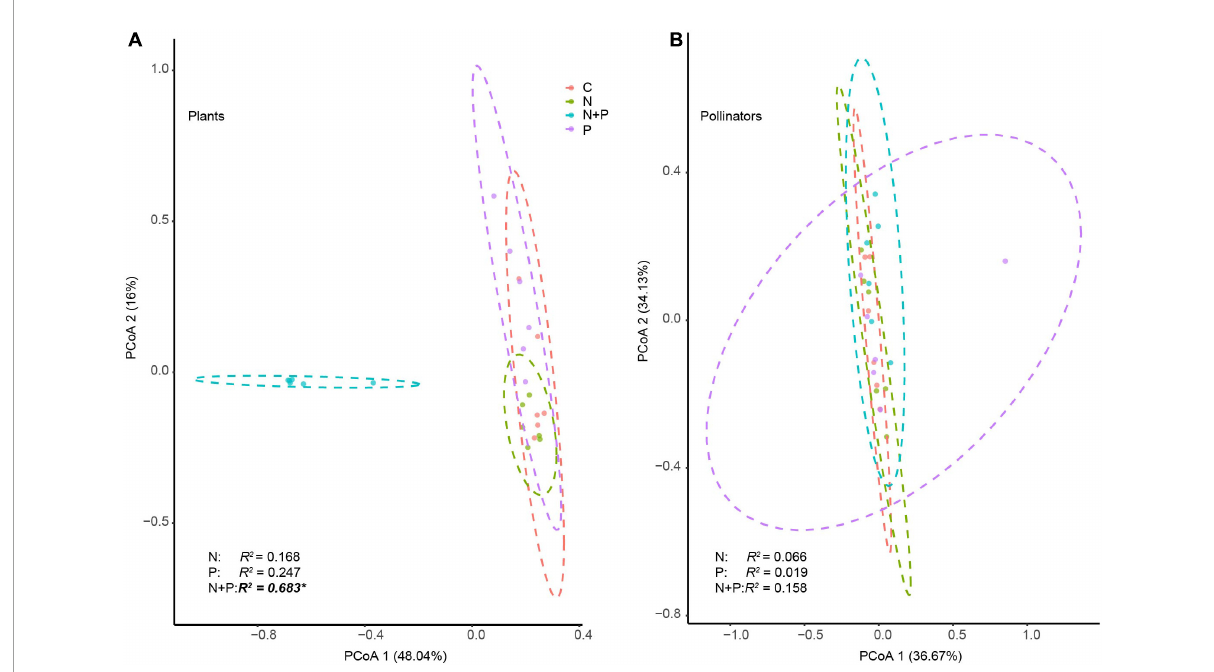
FIGURE3 The effects of nutrient enrichment on the community structure of plant (A) and pollinator species (B) . The structure is based on a principal coordinate analysis. Permutation analysis of variance was used to evaluate the influence of N addition, P addition, and N and P co-addition on the community structure of plants and pollinators. The asterisk (*) indicates a significant difference at the 0.05